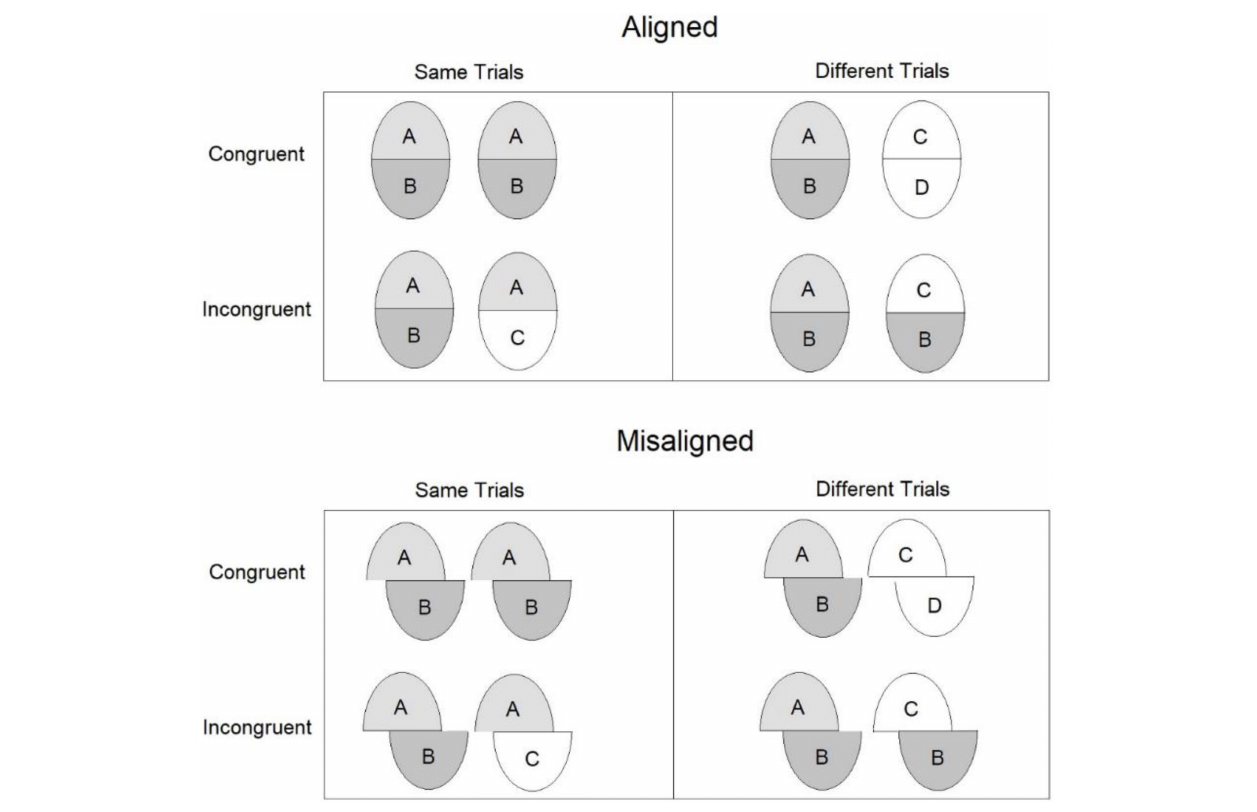
FIGURE 2 | Overview of the design of the sequential matching task. Each pair of faces designates a study and test pair. The complete design measure is based on all pairs, whereas the partial design measure is based only on the trials in the ‘same – incongruent’ conditions for aligned and misaligned